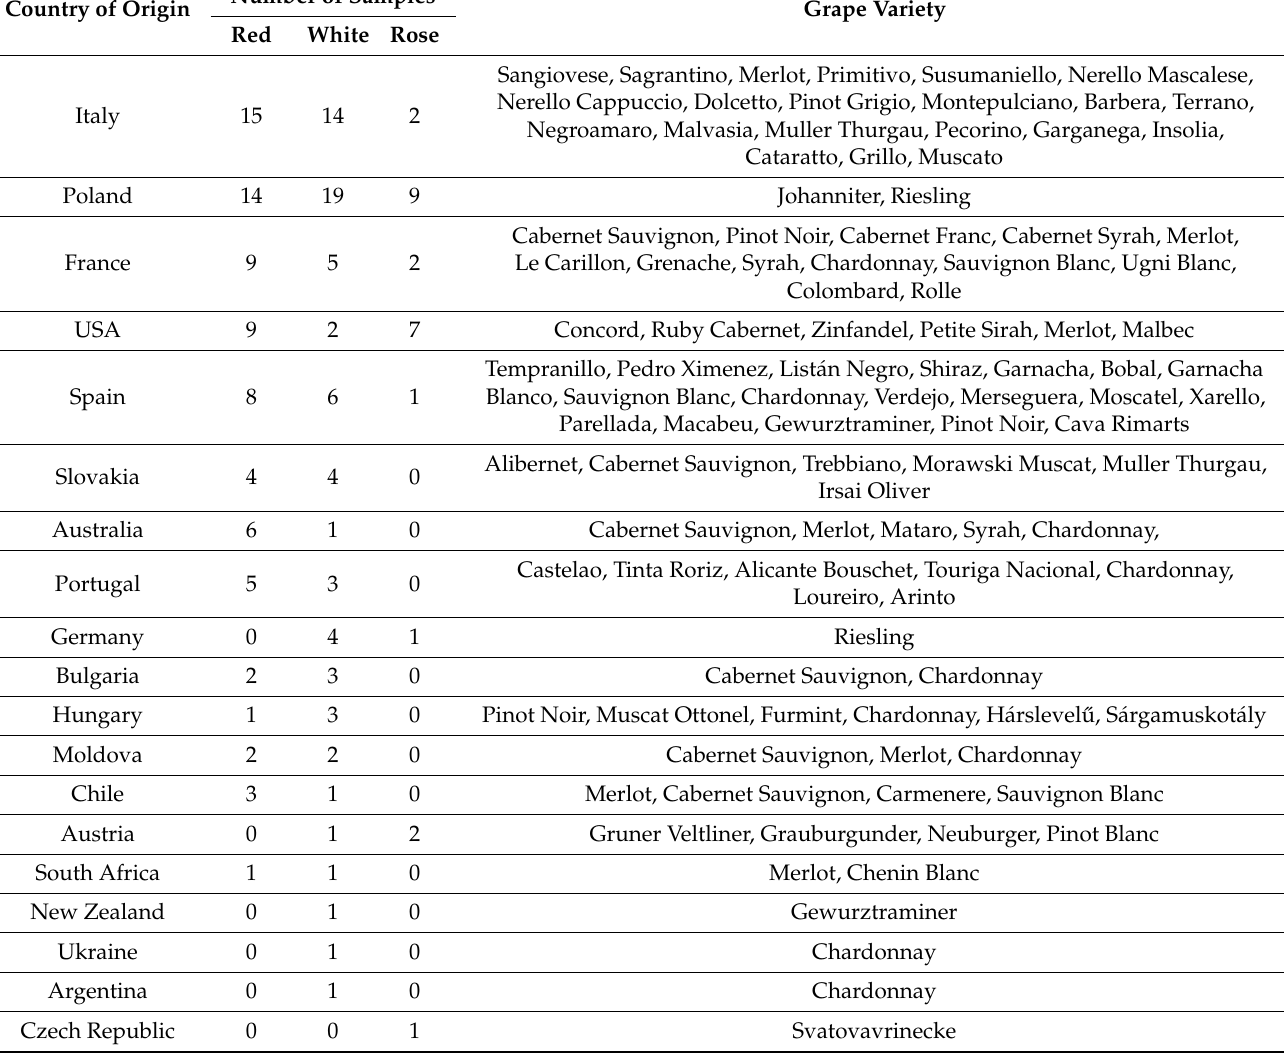
Table 3. Characteristics of tested samples in relation to their